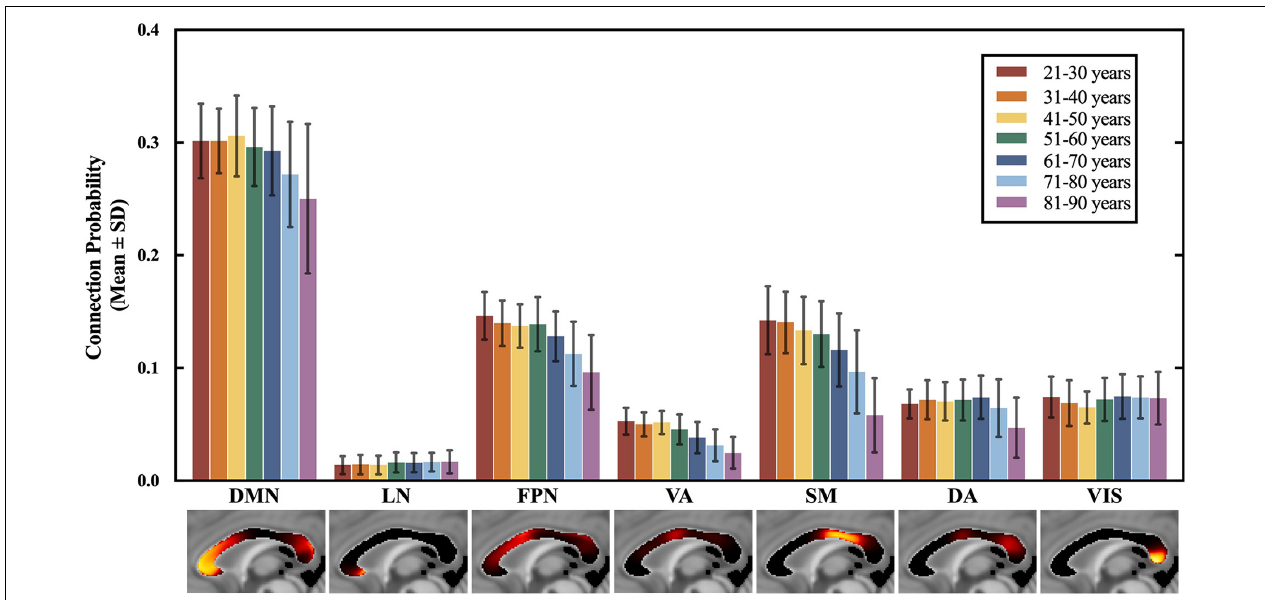
FIGURE 3 | The connection probability of 7 CC subregions across all 7 age groups. The mean and standard deviation of the regressed P ( s , n ) of each age group are plotted in the order of the spatial locations of all CC subregions, generally from the anterior to posterior part in the CC. ANCOVA showed significant differences among the 7 age groups for the subregions to DMN, FPN, VA, SM, DA, and VIS, which exhibited an anterior-to-posterior changing gradient. The subregions to DMN, FPN, VA and SM that are located in the anterior and middle part of the CC showed an earlier and severer decrease in the connection probability than the subregion to DA and VIS in the posterior CC. Statistical analysis of the paired comparisons is shown in Supplementary Table 2 . VIS, CC subregion connecting to the visual network; SM, CC subregion connecting to the somatomotor network; DA, CC subregion connecting to the dorsal attention network; VA, CC subregion connecting to the ventral attention network; LN, CC subregion connecting to the limbic network; FPN, CC subregion connecting to the frontoparietal network; DMN, CC subregion connecting to the default mode